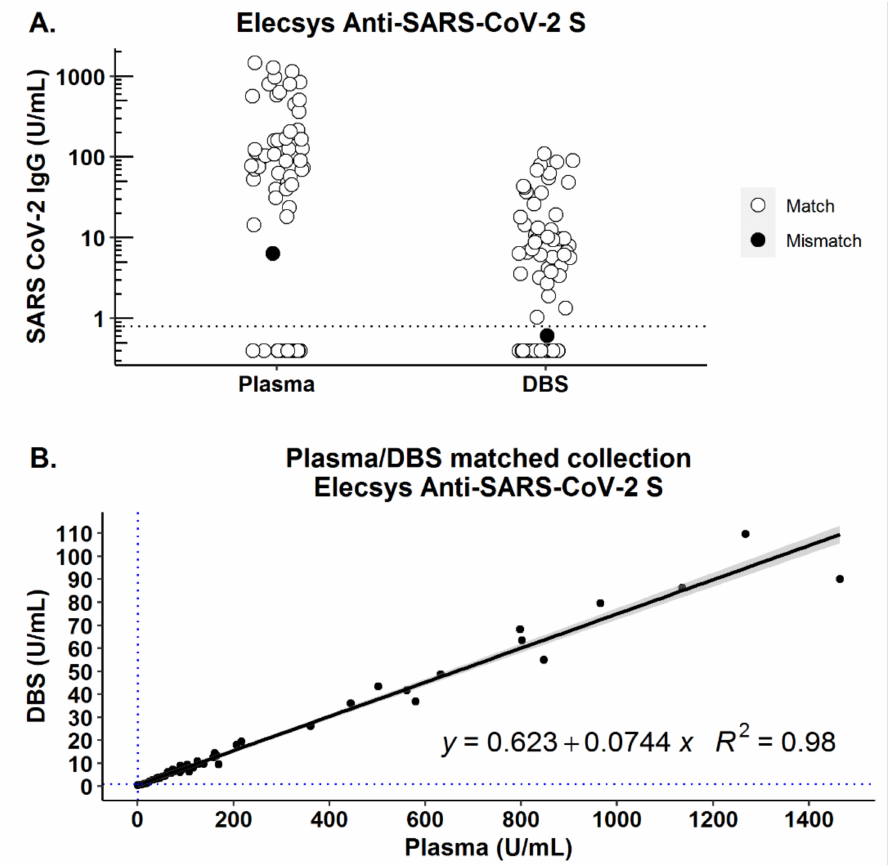
Figure 2. Plasma and dried blood spot collection comparison. Plasma and DBS samples collected in parallel from the same participant were processed and analyzed by Roche Elecsys Anti-SARS-CoV-2 (S) assay ( n = 52 COVID-19-positive, n = 11 COVID-19-negative). Horizontal line indicates assay threshold as quoted by manufacturer for plasma/serum. ( A ) Distribution of values in plasma and DBS samples for mismatched samples ( • ) and matched samples (o). ( B ) Dataset from ( A ) showing correlation between concentrations obtained from plasma vs.